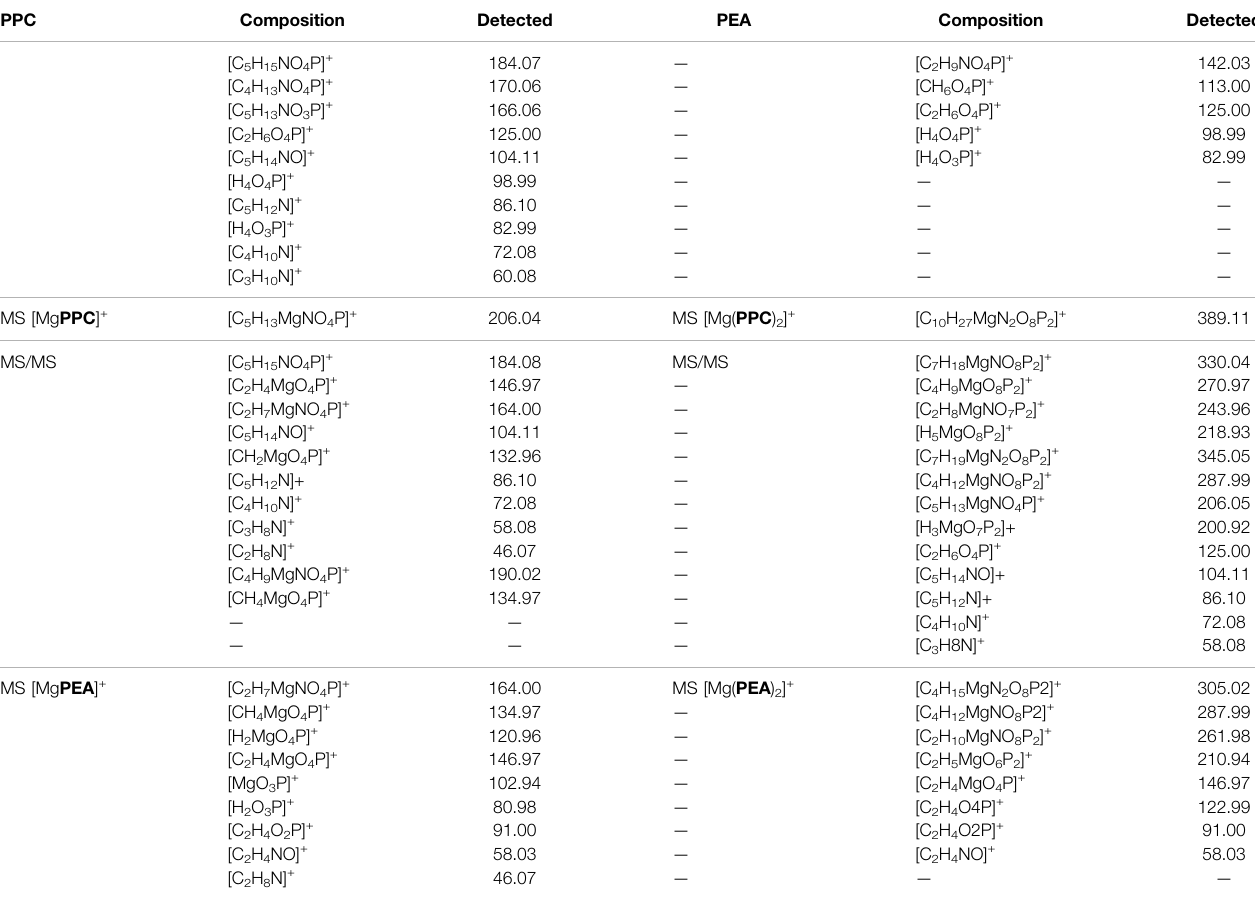
TABLE 5 | MS and MS/MS ion fragments of ligands and Mg 2+ species. PPC